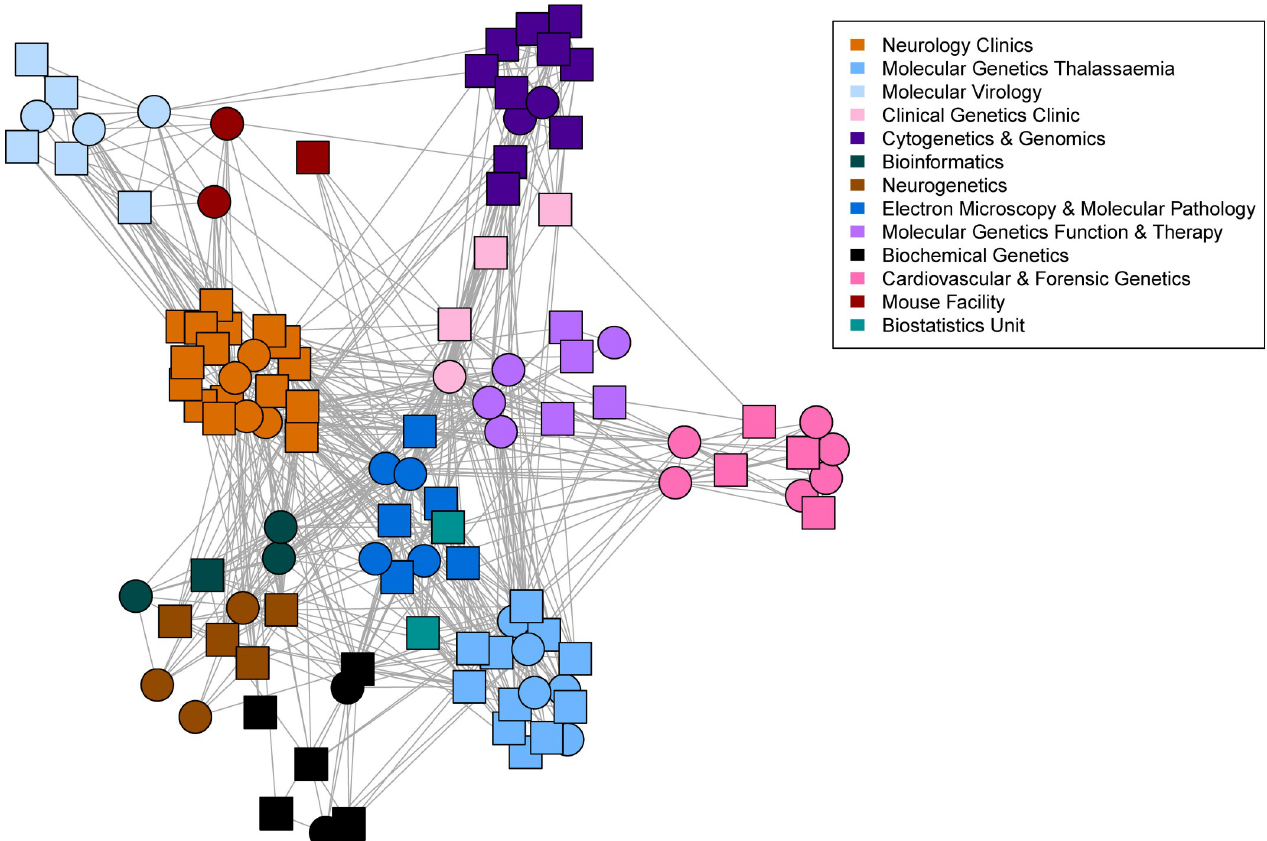
Fig 6. Departmental co-authorship network of CING employees. Square nodes indicate female authors and circle nodes indicate male authors. Node colour indicates department affiliation whereas a link between two nodes/authors indicates co-authorship of at least one research paper.